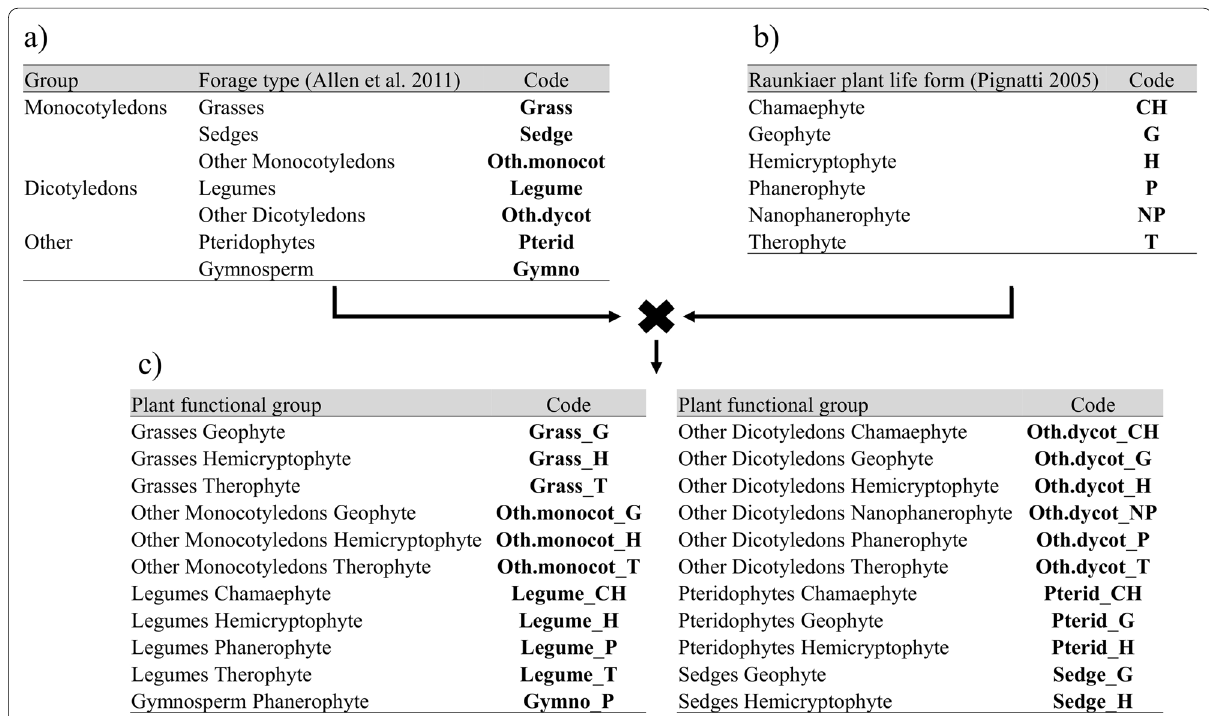
Fig. 2 Identification pattern of the plant functional groups: a Forage type (according to Allen et al. 2011), b Raunkiaer life forms (according to Pignatti 2005), and c Plant functional